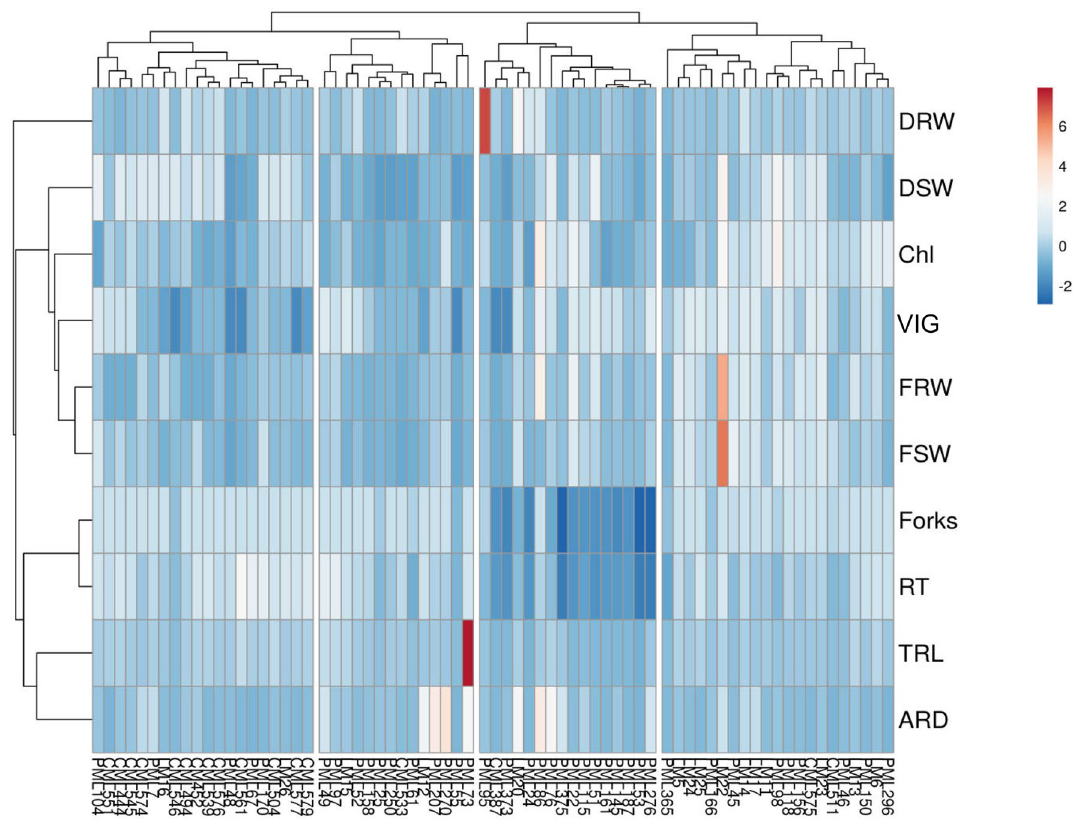
Figure 3. Heatmap depicting four clusters for 71 inbreds based on ten seedling traits. The colour code from darker blue to darker red represents the lower to higher values for root and shoot traits under water deficit condition.